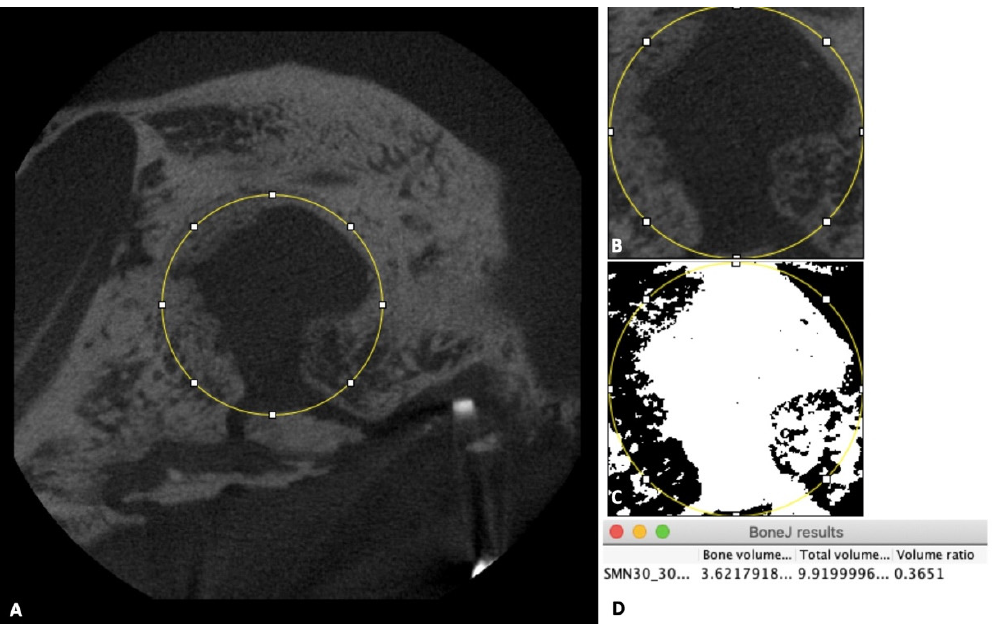
Figure 3. Micro-CT evaluation. ( A ) Image of the 4-mm-diameter circle including the initial defect and new bone inside the defect. ( B ) Illustration of the new 3D volume after using the “Duplicate” tool. ( C ) Illustration of the new 3D volume after using the “Make binary” tool. ( D ) Box shows final results.